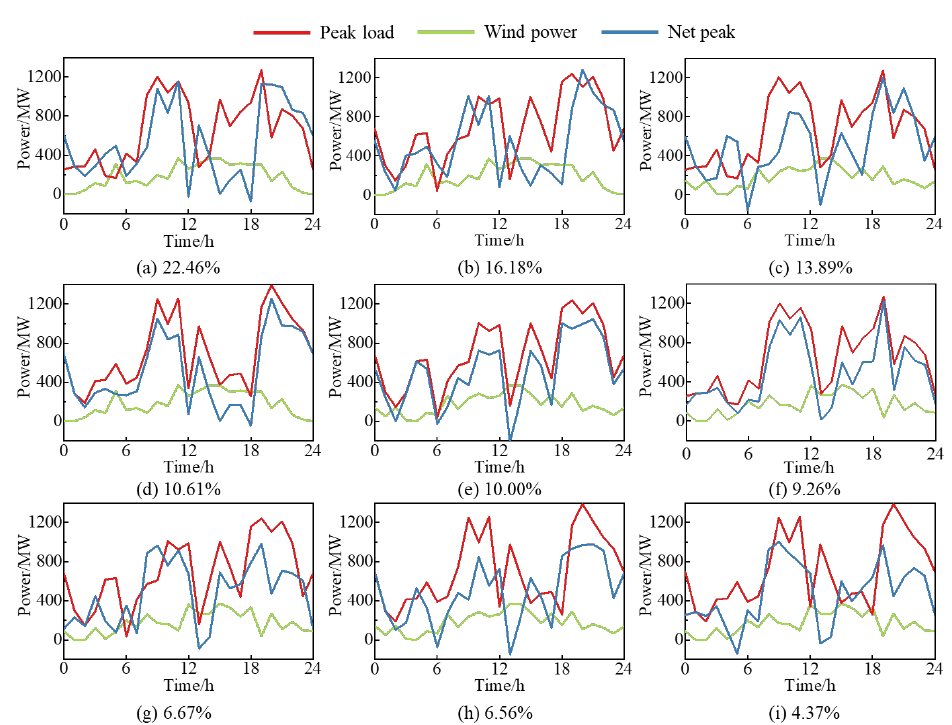
Figure 7. Net load under the different scenarios: ( a ) 22.46%; ( b ) 16.18%; ( c ) 13.89%; ( d ) 10.61%; ( e ) 10.00%; ( f ) 9.26%; ( g ) 6.67%; ( h ) 6.56%; and ( i ) 4.37%. Table 3. Net load based on nine reduced scenarios.